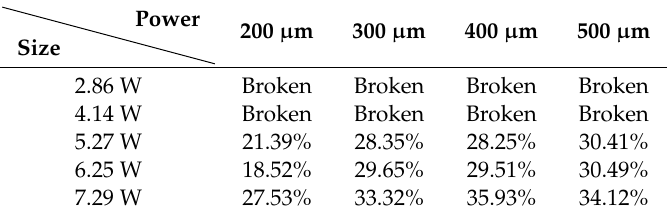
Table 1. E ff ects of laser power and wall thickness on filling